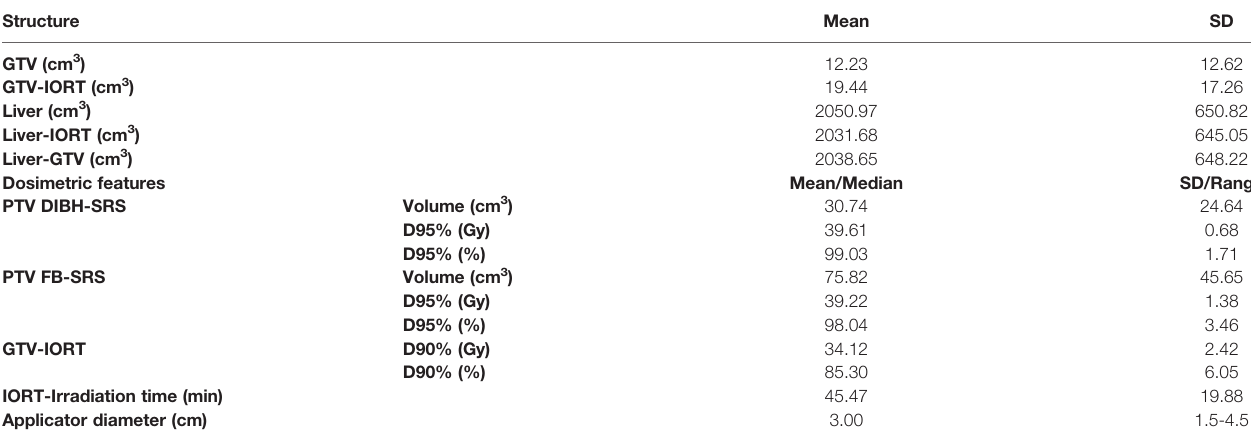
Target and liver volumes expressed in cm 3 . Target coverage displayed in absolute Gy and relative (percental) values. The median applicator diameter and mean simulated irradiation time are additionally shown. GTV, gross tumor volume; IORT, intraoperative radiotherapy; PTV, planning target volume; DIBH, deep inspiration breath hold; SRS, stereotactic radiosurgery; FB, free-breathing; SD, standard